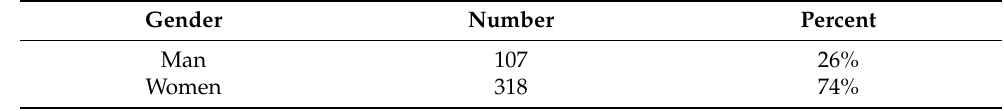
Figure 1. Structure of respondents by religion. Source: authors’ own elaboration. Table 1. Gender structure.